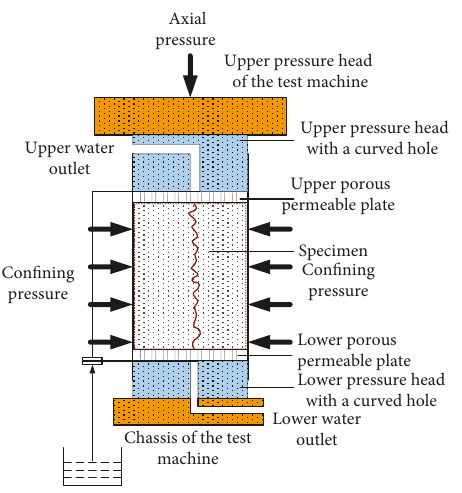
Figure 2: Sketch of fracture seepage